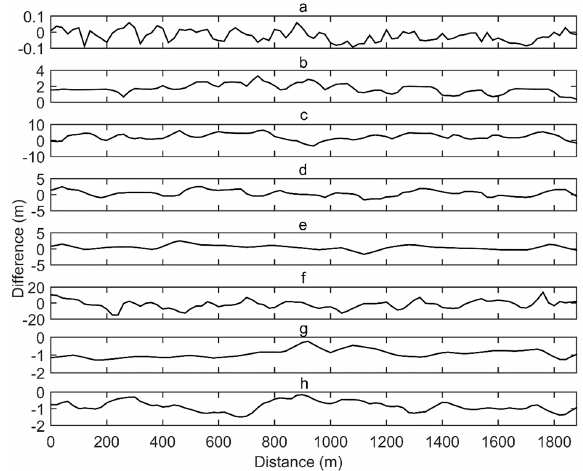
Figure 4. Plots of height differences between profiles extracted from the investigated DEMs minus the leveling along the runway’s centerline: ( a ) aerial photogrammetry DEM; ( b ) ASTER; ( c ) AW3D30; ( d ) SRTM-1”; ( e ) SRTM-3”; ( f ) SRTM-X; ( g ) TanDEM; ( h ) WorldDEM TM . Note the different vertical scales on the vertical axes.